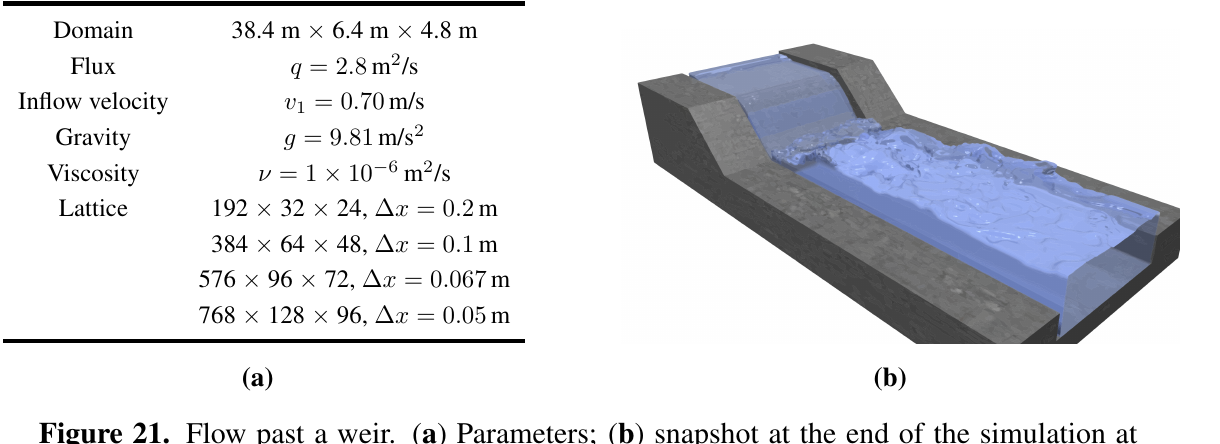
Figure 21. Flow past a weir. ( a ) Parameters; ( b ) snapshot at the end of the simulation at t = 60